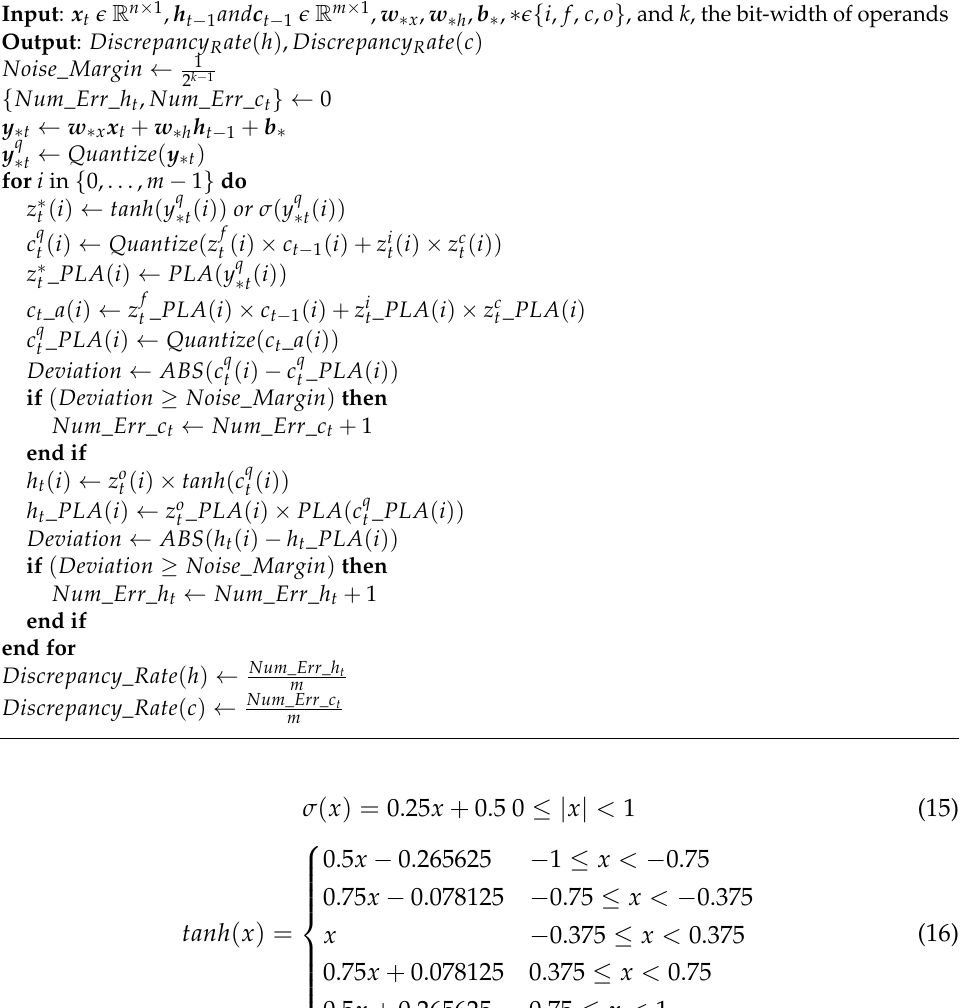
Algorithm 1 Pseudocode in calculating the discrepancy rate regarding the PLAed activation function and its quantized